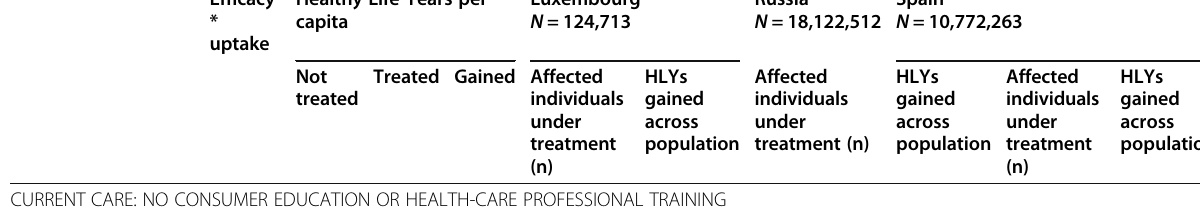
Table 10 Healthy Life Years (HLYs) potentially gained in 1 year by each element of the proposed intervention (TTH) Efficacy * uptake